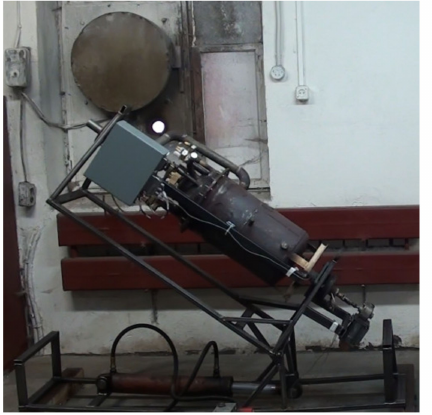
Figure 5. Change in the inclination of gas generator by angle α